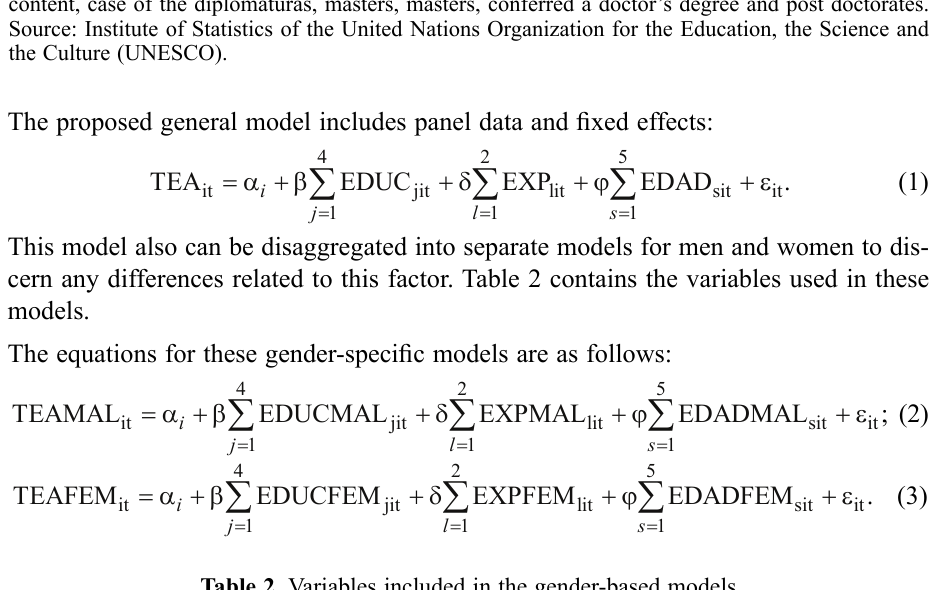
Table 2. Variables included in the gender-based